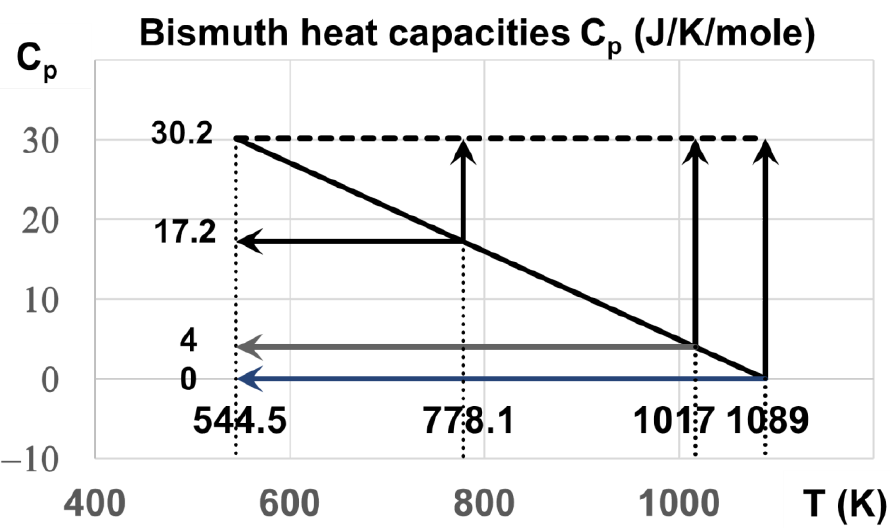
Figure 7. Heat capacities of bismuth in J/K/mole. C p = 30.2 from T = 544.5 to 1089 K in the absence of glass phase. C p = 17.2 from T m = 544.5 to T g = 778.1 K in the presence of glassy fraction f = 42.908%. C p = 4 from T m = 544.5 to T g = 1017 K in the presence of a glassy fraction f = 86.75%. C p = 0 for f = 100%. Heating beyond T g , leads to C p = 30.2 inside the transition width. Cooling from a temperature slightly below T g leads to the glassy state.